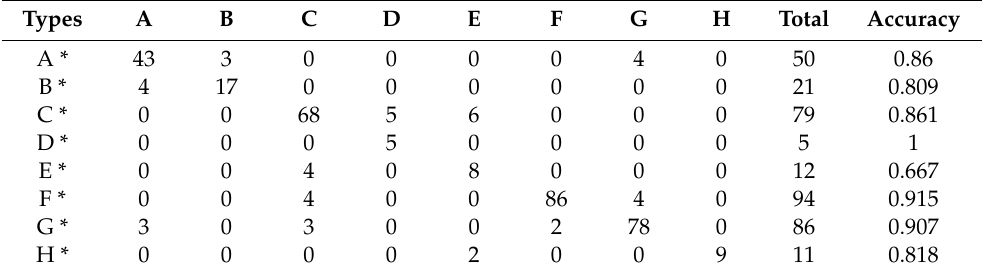
Table 5. Confusion matrix of multi daily activities-based classification. Science education (A),